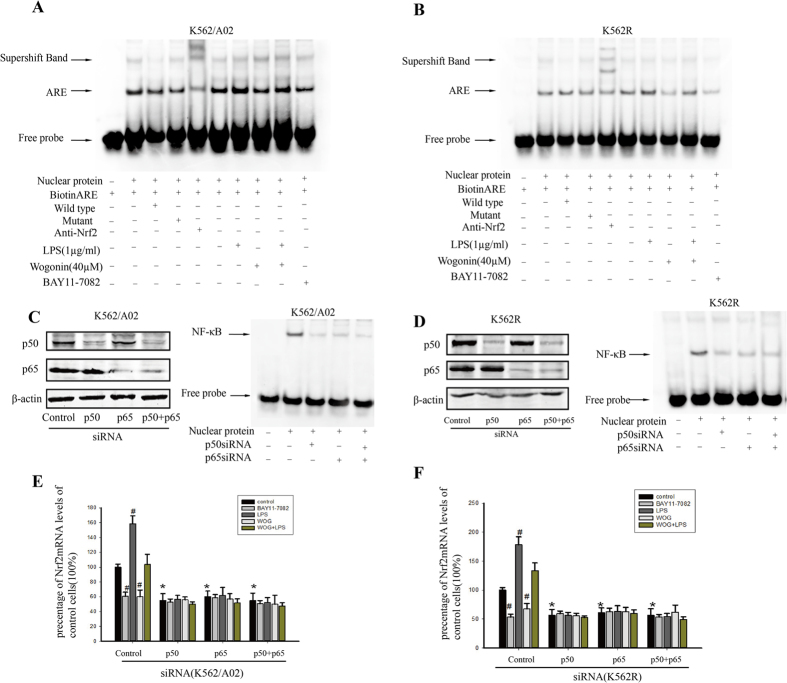
Inhibition of the κB activity was responsible for reducing Nrf2 transcription by Wogonin.(A,B) 40 μM Wogonin and 5 μM BAY11-7082 reduced the binding of Nrf2 to ARE, respectively. However, the inhibition of the binding of Nrf2 to ARE sites was reversed by treatment with 1 μg/ml LPS. Nrf2/ARE DNA binding activity was assessed by EMSA after treatment with 40 μM Wogonin or BAY11-7082 in the presence or absence of LPS. (C,D) Left: Cells were treated by silencing p50 or p65, individually and in combination, and then the level of p50 and p65 was detected by Western blot analysis in K562/A02 and K562R cells. Right: After cells transfected with the indicated siRNAs, NF-κB DNA binding activity was assessed by EMSA. (E,F) K562/A02 and K562R cells were transiently transfected with indicated siRNAs shown in each plot and controlsiRNA for normalization of transfection efficiency. Cell extracts were harvested, and the level of Nrf2 mRNA was determined by RT-PCR. LPS (1 μg/ml) treatment acted as a positive control to activate NF-κB and BAY 11-7082 (5 μM) to inhibit NF-κB. *p < 0.05 versus transfected with controlsiRNA in untreated cells. #p < 0.05 versus untreated controls. All results were represented as the mean ± SD of three independent experiments.